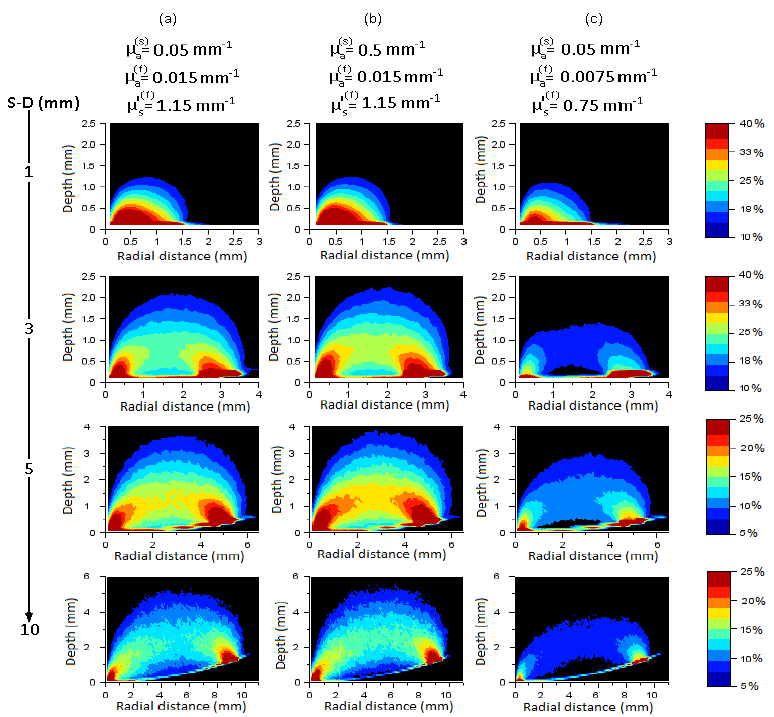
Figure 8. Source-detector sensitivity profiles computed for a skin thickness d = 80 µm, four source-detector distances S-D = 1 mm, 3 mm, 5 mm and 10 mm (horizontal columns), and different combinations of optical properties µ ’ s ( s ) = 4 mm ´ 1 - µ a ( s ) ; µ a p f ) - µ ’ s ( f ) (vertical columns ( a - b - c )). Table 3. Retrieved internal optical properties ( µ a - µ’ s ) and errors (Δ µ a %, Δ µ ’ s %) estimated with respect to the true values ( µ a ( f ) - µ ’ s ( f ) ).